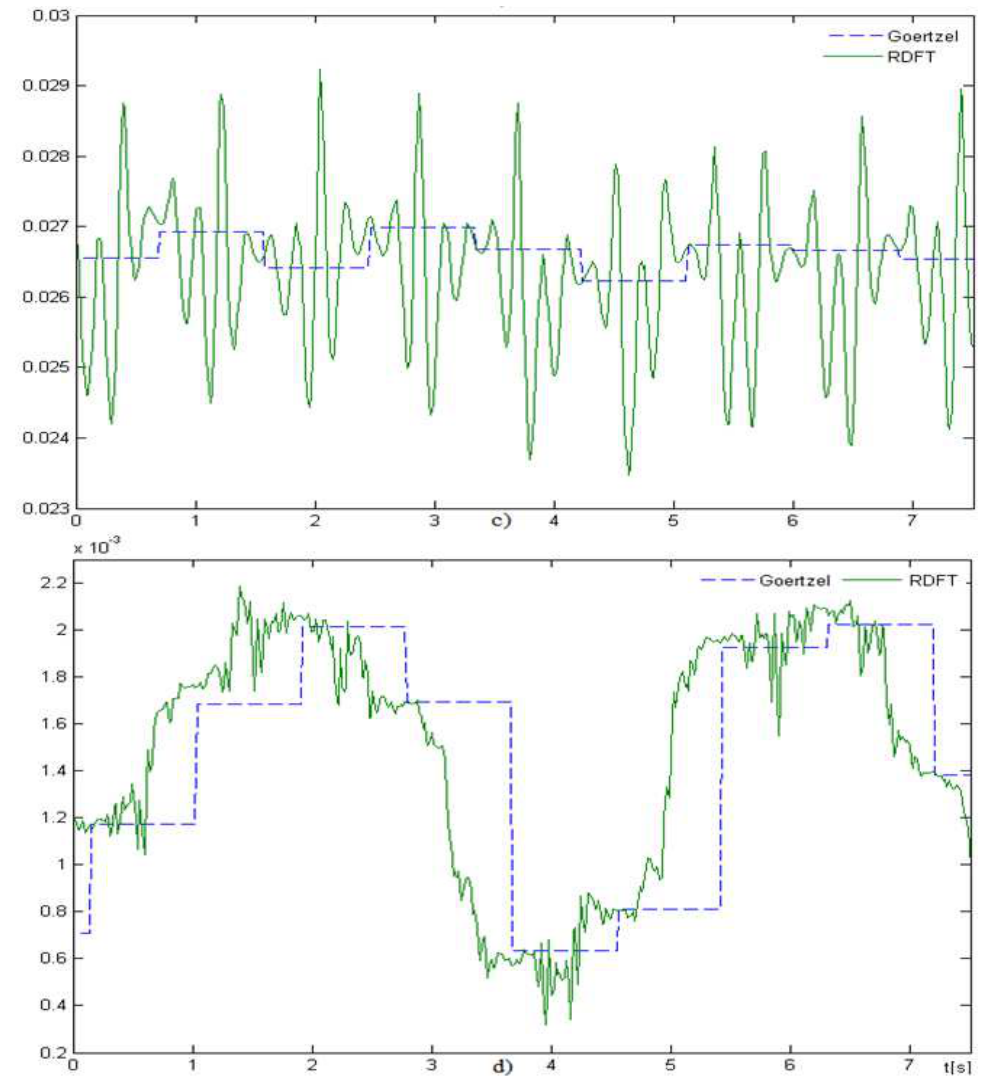
Figure 6. Real-time amplitude estimation of the rotor fault related harmonic for Goertzel and RDFT algorithms at ω r = 0.65, T L = 0.72 and ( a ) Scalar control V/f = const and rotor fault, ( b ) Scalar control V/f = const and healthy rotor, ( c ) Multiscalar vector control and broken rotor, ( d ) Multiscalar vector control and healthy rotor.